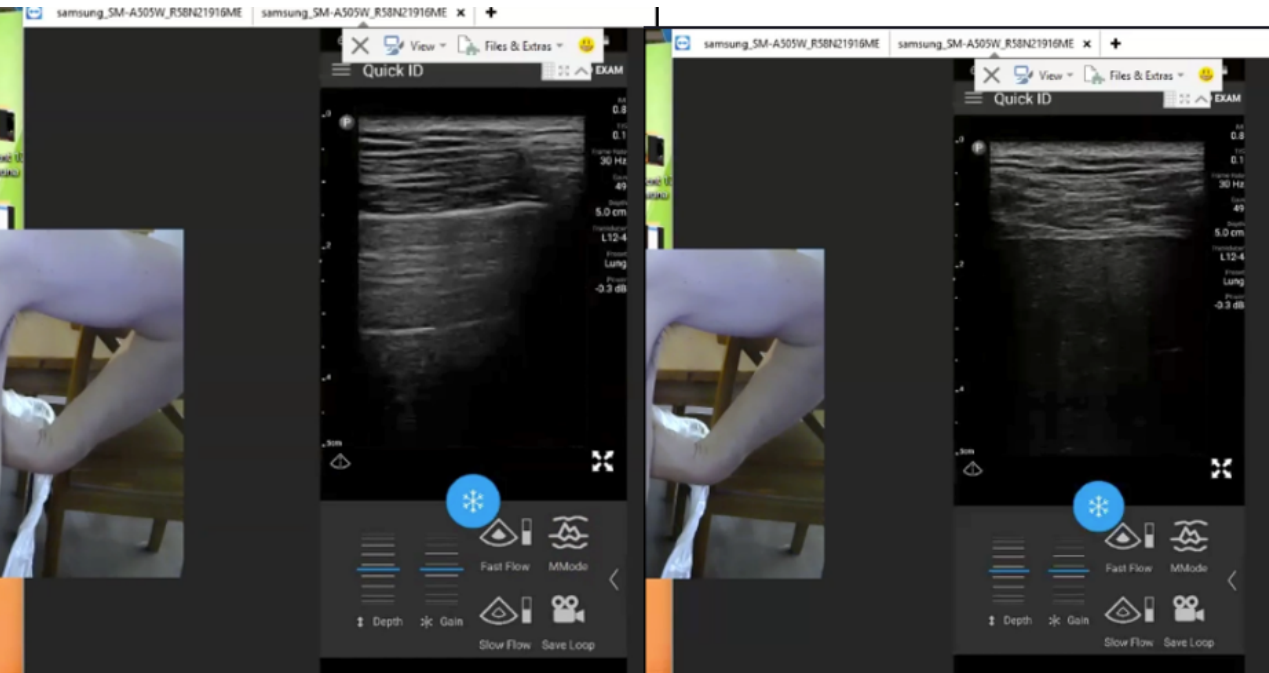
Figure 2. Example of the “Spleen Point” Sign confirming imaging of the Lung Base. Legend: When the ultrasound probe is correctly positioned at the bung base, the image will review the visceral- parietal interface (left) alternating with the parenchyma of the spleen on the left or liver on the right with no probe movement due to the respiratory movement of the diaphragm. Note: Lung ultrasound is a dynamic science much better appreciated with real time imaging. The videorecording of the entire mentored Lung examination ca be viewed in Supplementary File S2.